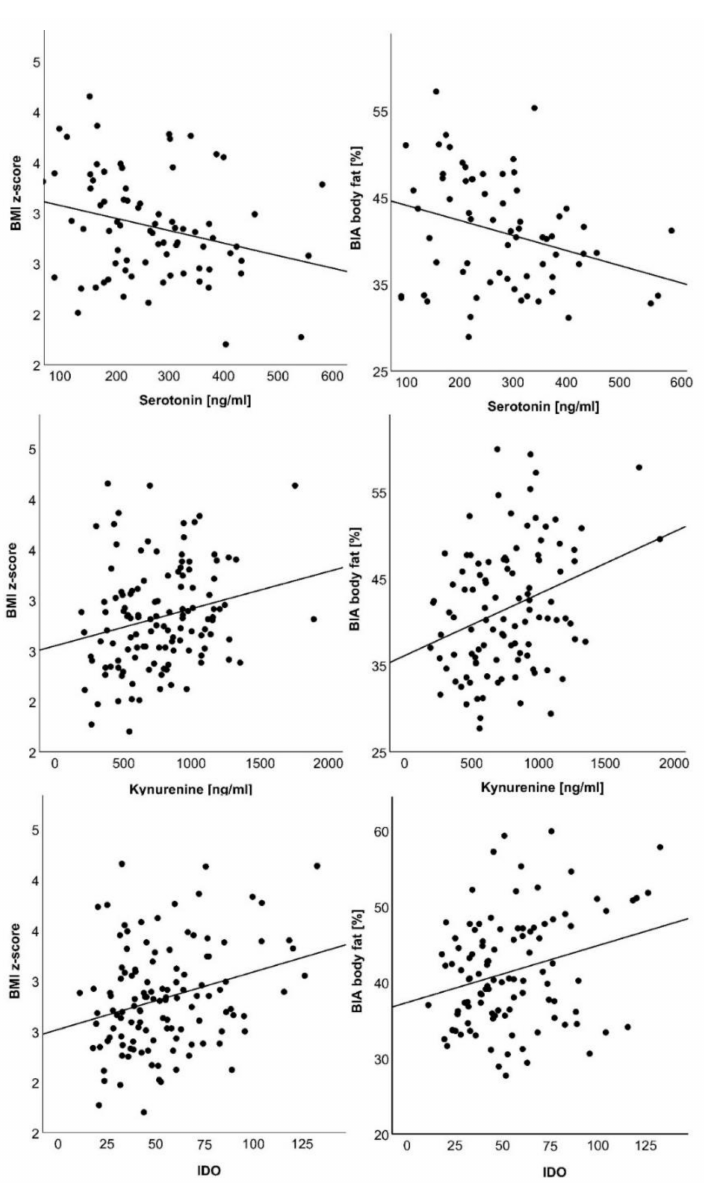
Figure 1. Correlations of IDO activity, kynurenine and serotonin with BMI z-score and body fat percentage (BIA body fat). Respective values are plotted as indicated in the diagram